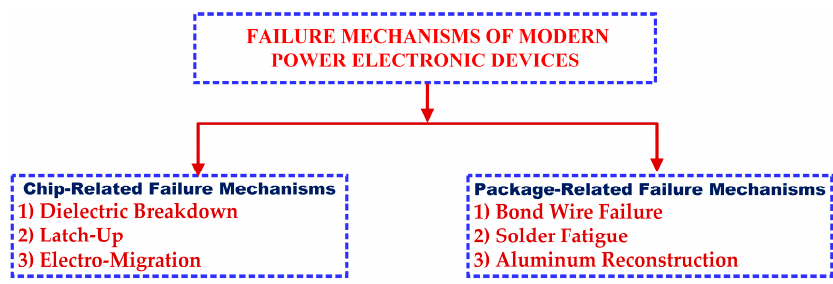
Figure 14. The Failure Mechanisms of Contemporary Power Electronic Devices.